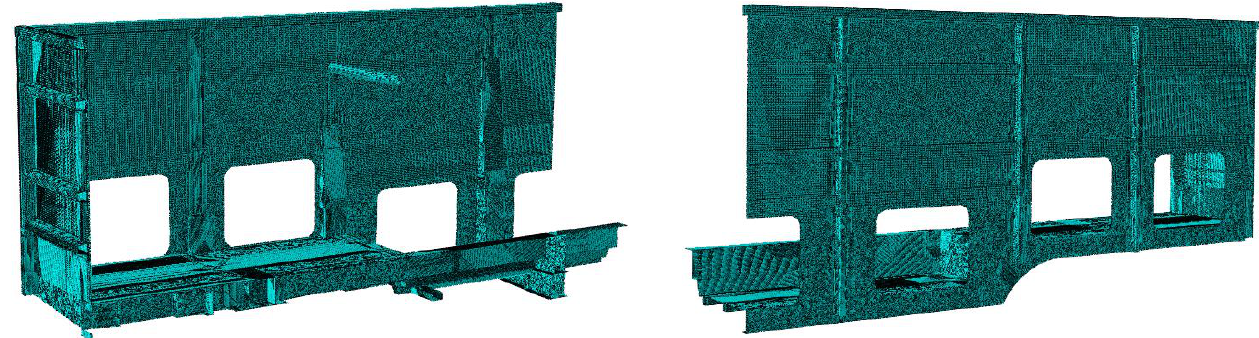
Figure 6. Finite element model of the gondola car body.